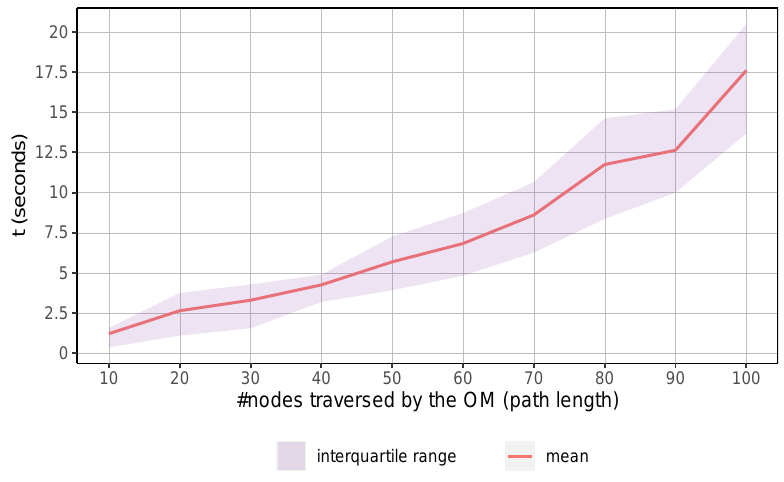
Figure 8. Required time for an OM to travel the selected path length. Measurements do not include the OM processing delay. Statistics are computed for 30 OMs at each OM path